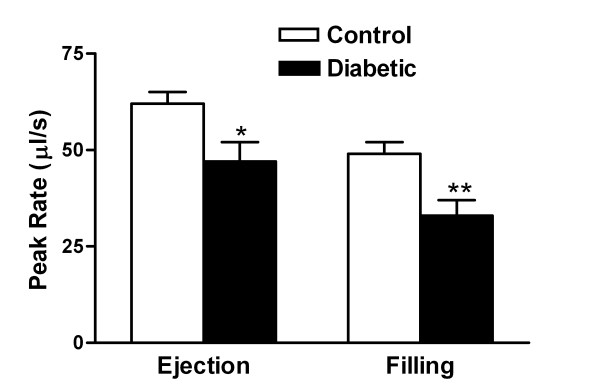
Peak LV ejection and filling rates calculated from the maximum slopes of the volume-time curves for control and diabetic mice. These data were obtained from the LV volume-time curve for each mouse, as shown for a single mouse in Figure 3. Values are mean ± SEM. *P < 0.05 and **P < 0.01 vs. control, n = 8.